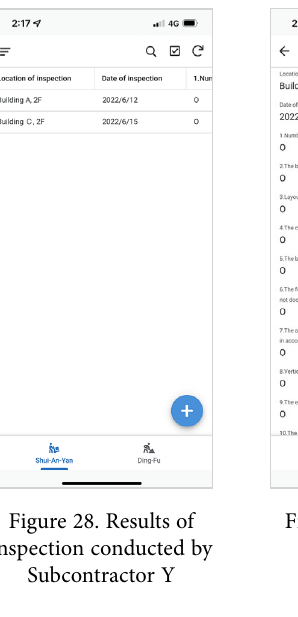
Figure 29. First set of inspection results